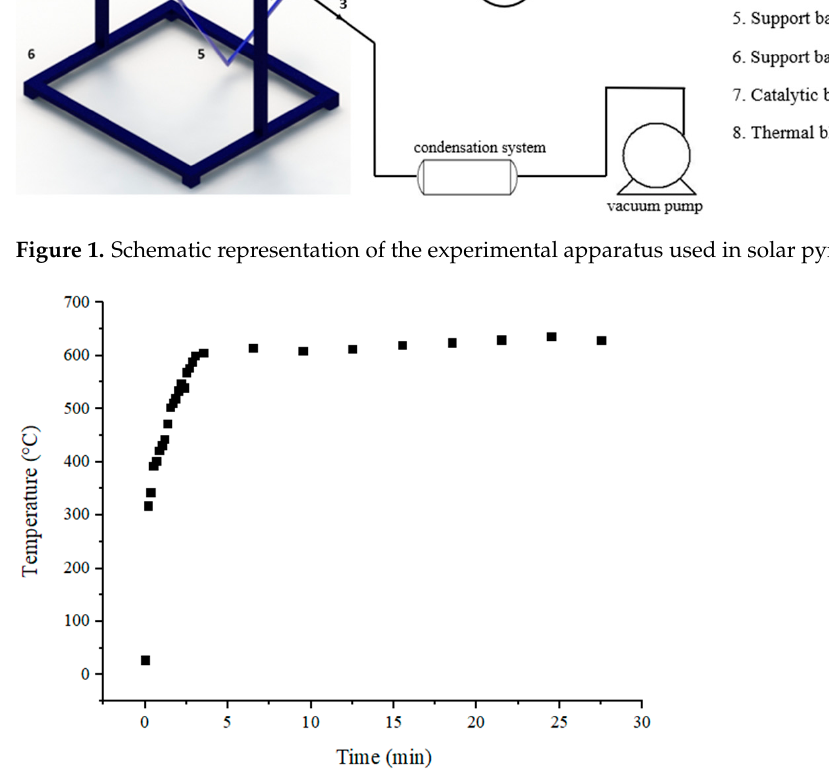
Figure 2. Heating ramp during solar pyrolysis tests.